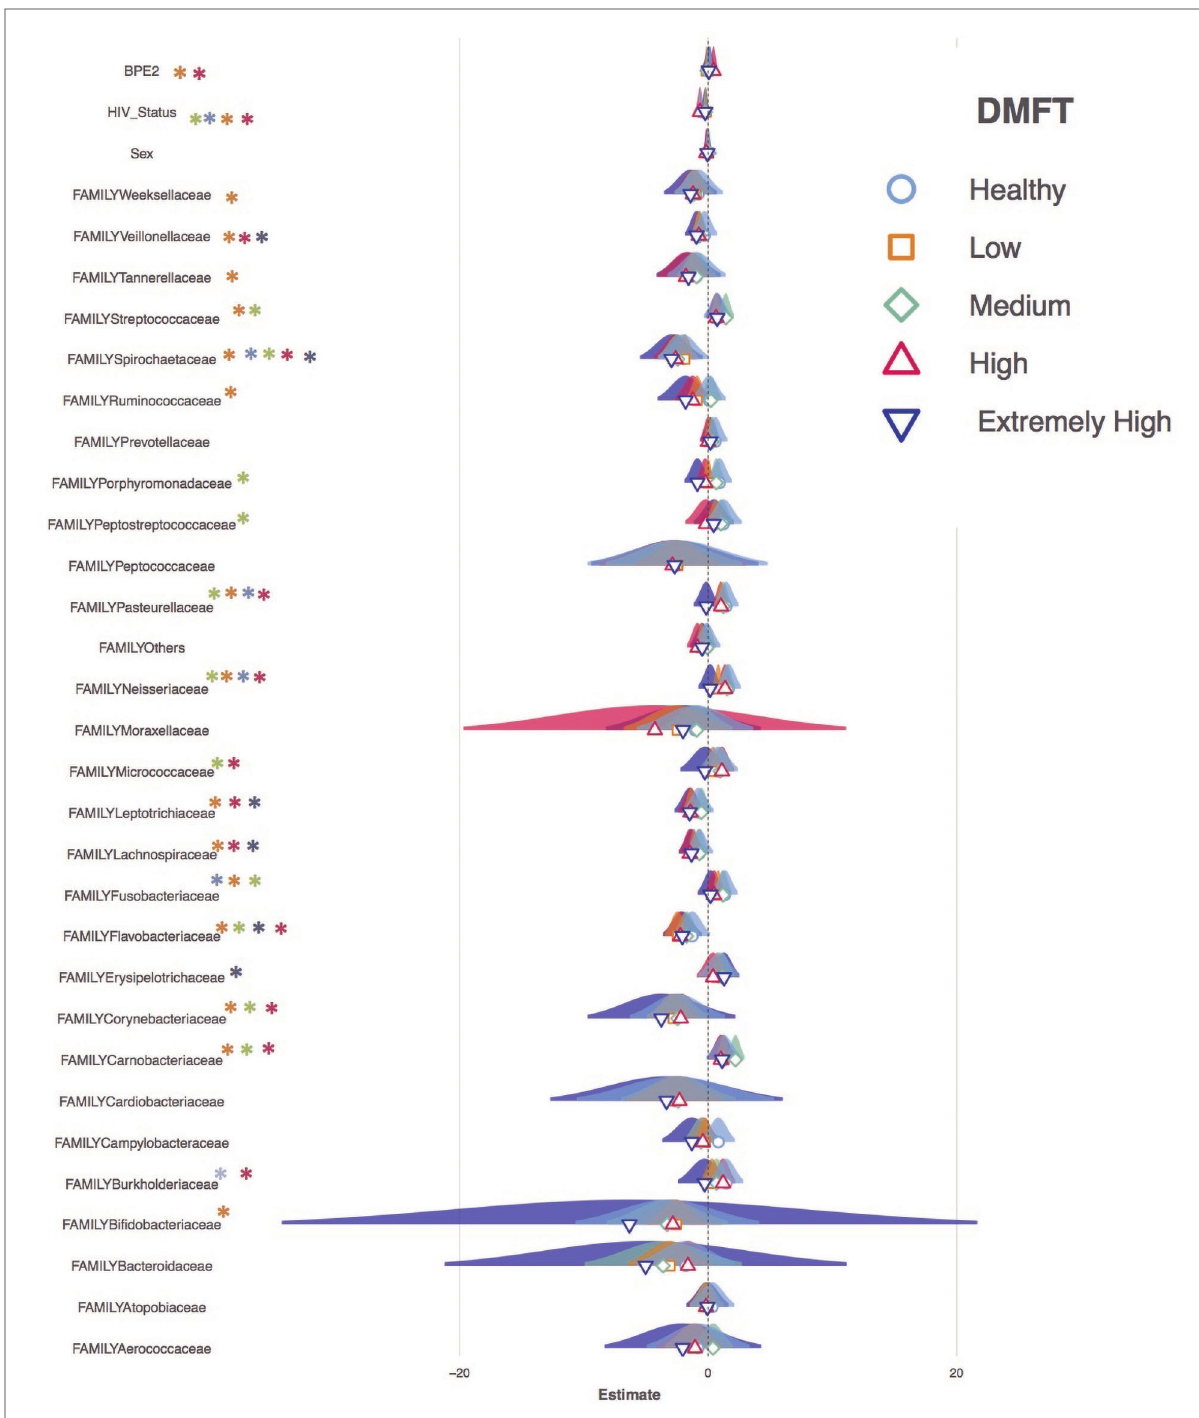
FIGURE 4 Shows the Poisson regression model of taxonomic abundance and clinical attributes, a comparison of models generated from datasets that represent each DMFT category. The Asterix colors shows in which dataset a variable is statistically signi fi